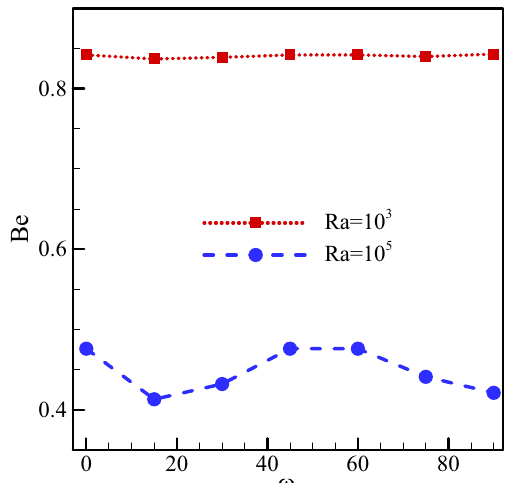
Figure 8. Bejan number for Ha = 20, Rd = 1, ϕ = 0.03, γ = 45 ◦ and various Rayleigh numbers and magnetic field angles.